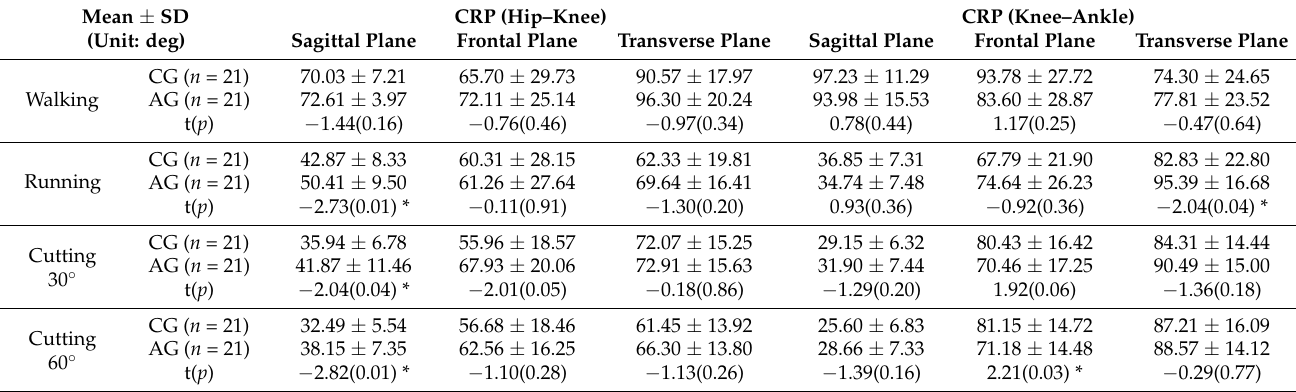
Table 2. Hip–knee and knee–ankle CRP by movement difficulty.